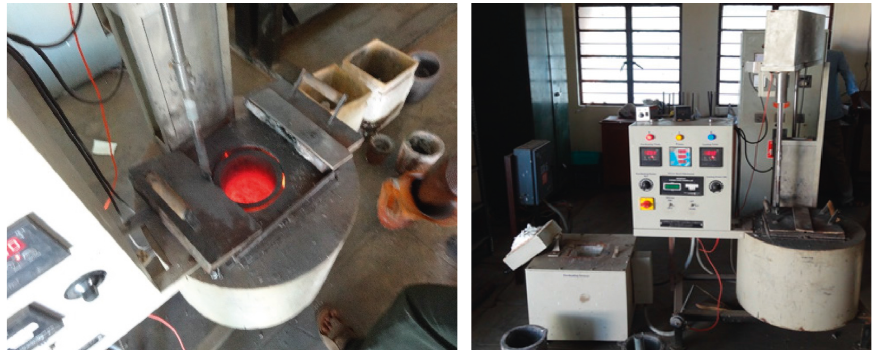
Figure 2: Synthesizing SiC/gr/Al7075 Table 2: Independent variables for WEDM. Table 3: Measured kerf width of brass, zinc coated, and diffused coated wires. Range of independent variables Independent variables